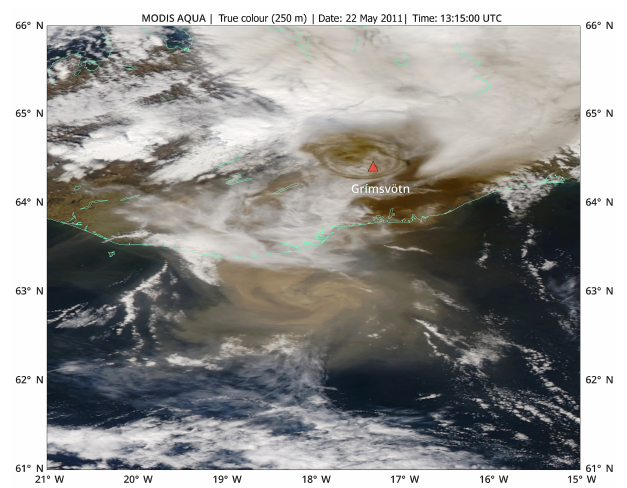
Figure 5. MODIS true-colour 250m resolution image of the Grímsvötn eruption column, showing the shadow cast on the ground and cloud below (to the N of the column). Note also the ash layer off the south coast that appears detached from the main column, sug- gesting that it is no longer being fed by ash from the vent. Image: MODIS/Aqua, 22 May 2011, 13:15UTC.